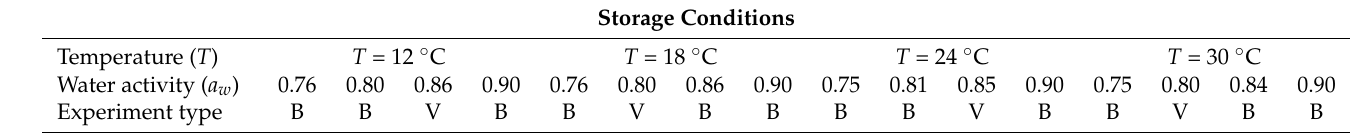
Table 4. Storage conditions: temperature and water activity in rapeseeds applied in experiments used for model development and validation and the type of experiment indicating the purpose of data use: B—building and